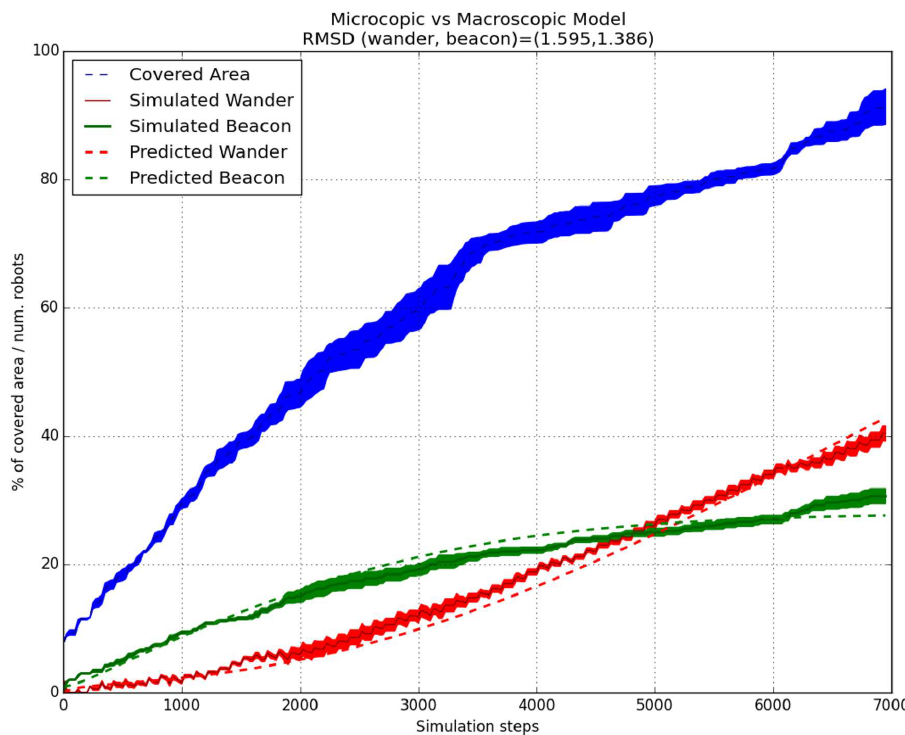
Fig 4. Comparison of the microscopic model with the macroscopic model for the labyrinth (center-right map) in Fig 3a, of size 100x100m and with pheromones radius of 20m. The mean and standard errors for both the number of individuals in each state of the simulation, and the number of individuals predicted by the macroscopic model are presented. In addition, the covered area c at each instant and the root-mean-square deviation of each state are a presented. Each simulation step is equal to 1/2